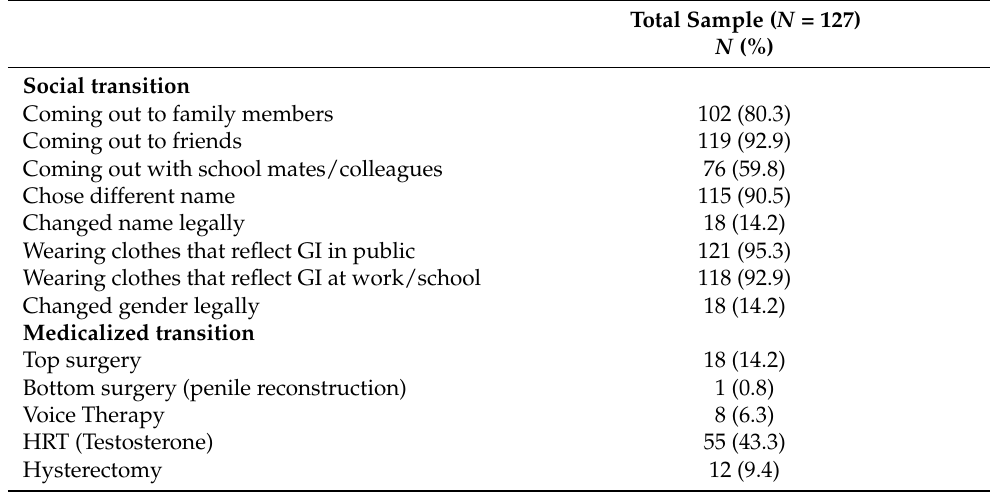
Table 1. Transition status. Social and medicalized transition steps taken by the